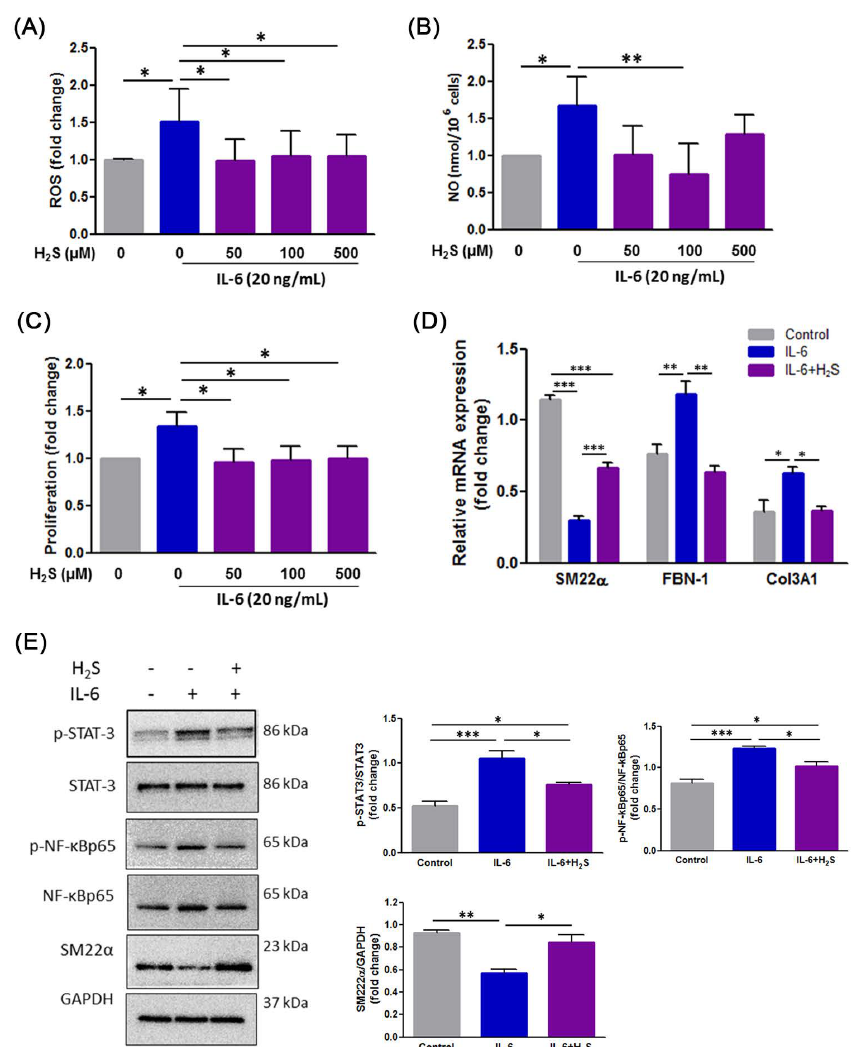
Figure 5. H 2 S effectively protects against IL-6 induced production of ROS and NO, and phenotypic switch in VSMCs. ( A ) The intracellular ROS level was detected using the fluorescent probe DCF- DA. ( B ) Changes in the NO level were measured using a Griess assay. ( C ) Cell proliferation was examined using a WST-1 assay. ( D ) RT–qPCR analysis of SM22 α , Fibrillin-1 (FBN-1), and Col3A1 mRNA in VSMCs. ( E ) Western blotting was performed to detect the expression of p-STAT3/STAT3, p-NFkBp65/NF-kBp65, and SM22 α . GAPDH was used as a loading control. Each result represents three separate experiments with qualitatively similar results. The data are expressed as mean ± SD. Statistical significance: * p < 0.05, ** p < 0.01, *** p <